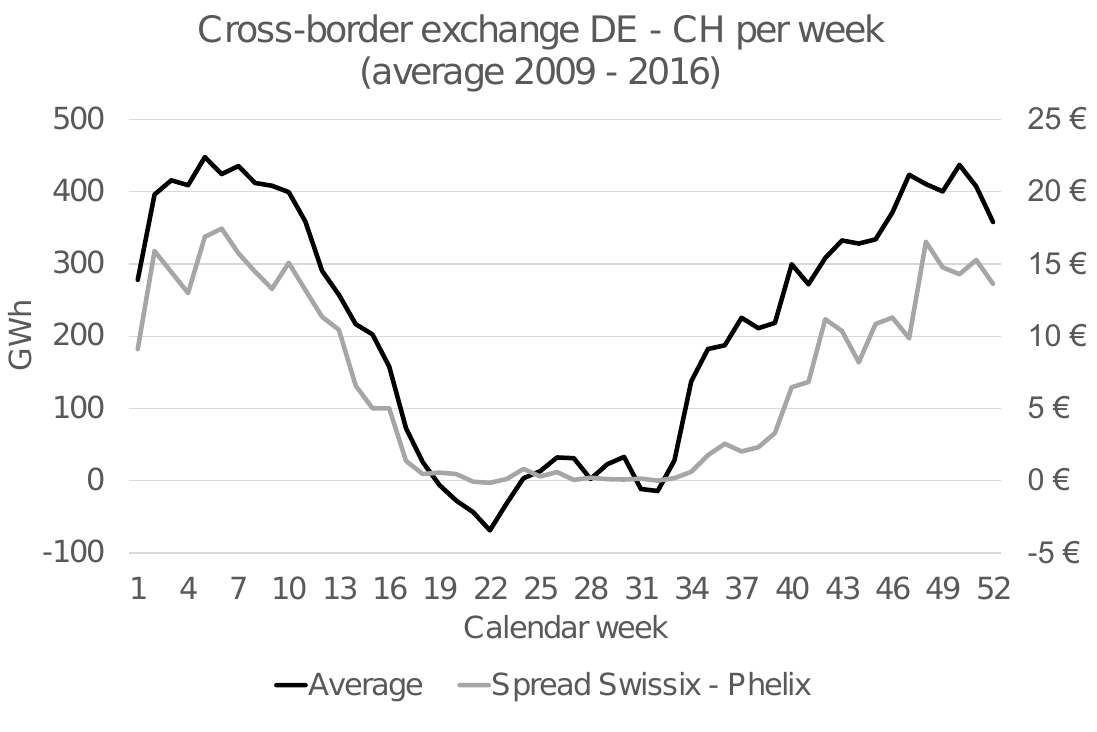
Figure 1. Physical cross-border net exchange between Germany and Switzerland (imports to Switzerland have a positive sign, exports to Germany have a negative sign) per calendar week, averaged between 2009 and 2016. In comparison, the weekly average spread between Swissix and Phelix is shown on the right axis.